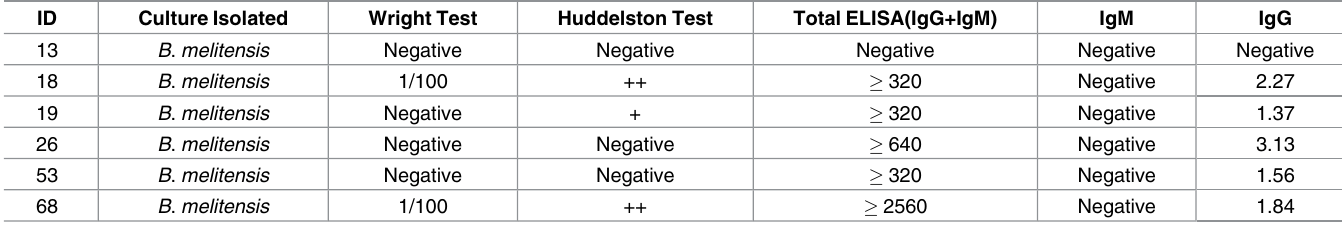
Table 4. Six patients positive by blood culture, but negative by Wright and/or ELISA